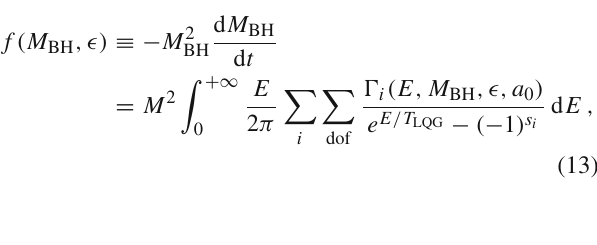
Fig. 3 Comparison of the HR of a massless spin 0 particle from a charged BH with charge Q = 0 . 985 M (dashed blue), a higher- dimensional BH with n = 6 (dotted green) and a polymerized BH with (cid:8) = 10 − 0 . 1 and a 0 = 0 . 11 (dot-dashed red) to a Schwarzschild BH (solid black) of the same mass M BH . The horizontal axis is labelled